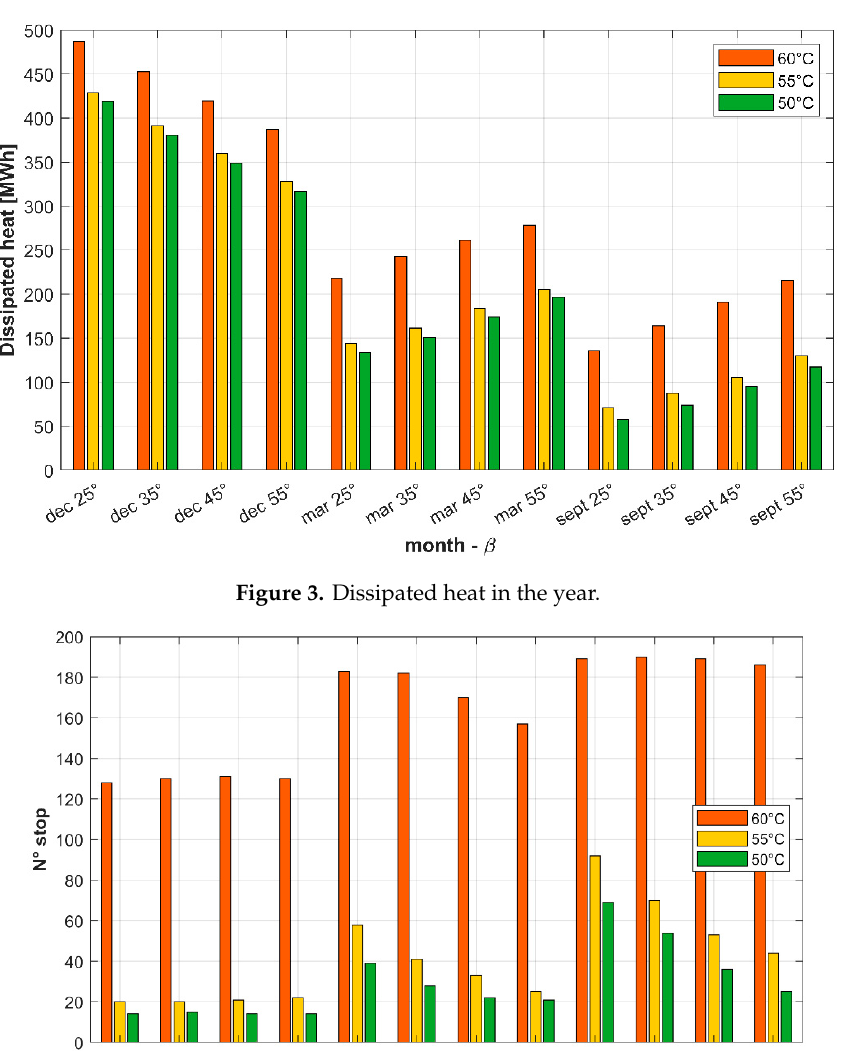
Figure 3. Dissipated heat in the year.